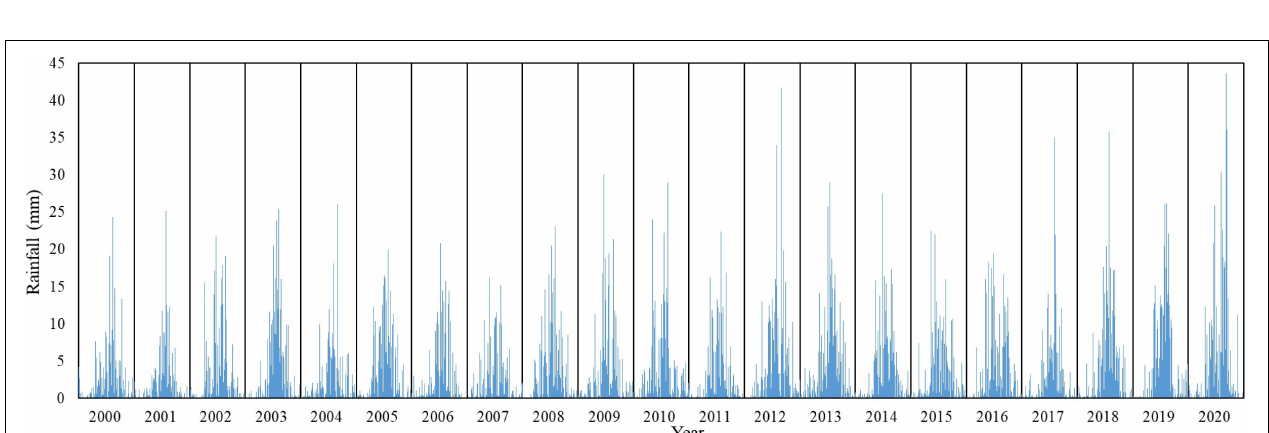
FIGURE A1 | Average daily precipitation in Songnen Plain from 2000 to 2020.